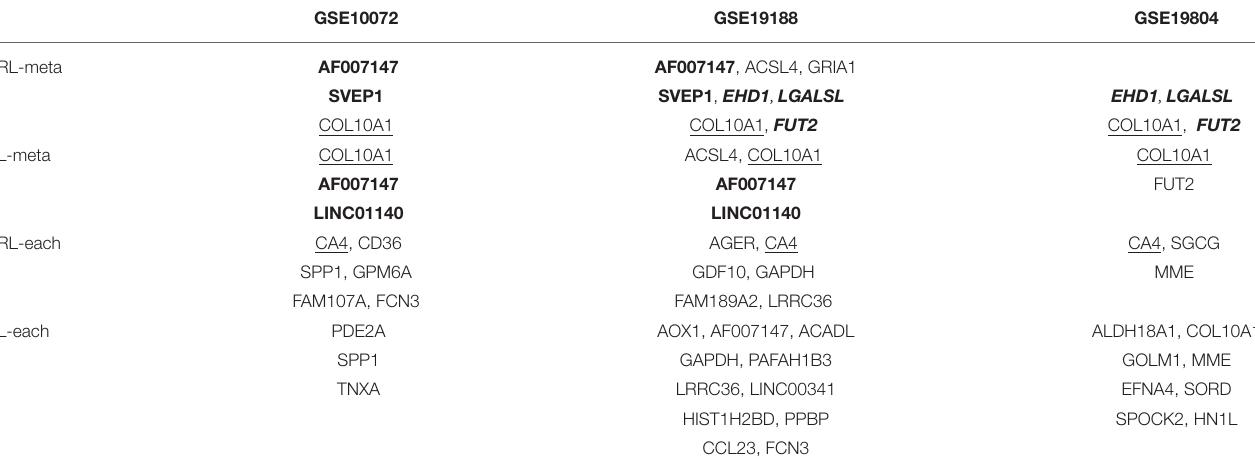
TABLE 5 | Gene selections of RL-meta, L-meta, RL-each, and L-each in three lung cancer studies.